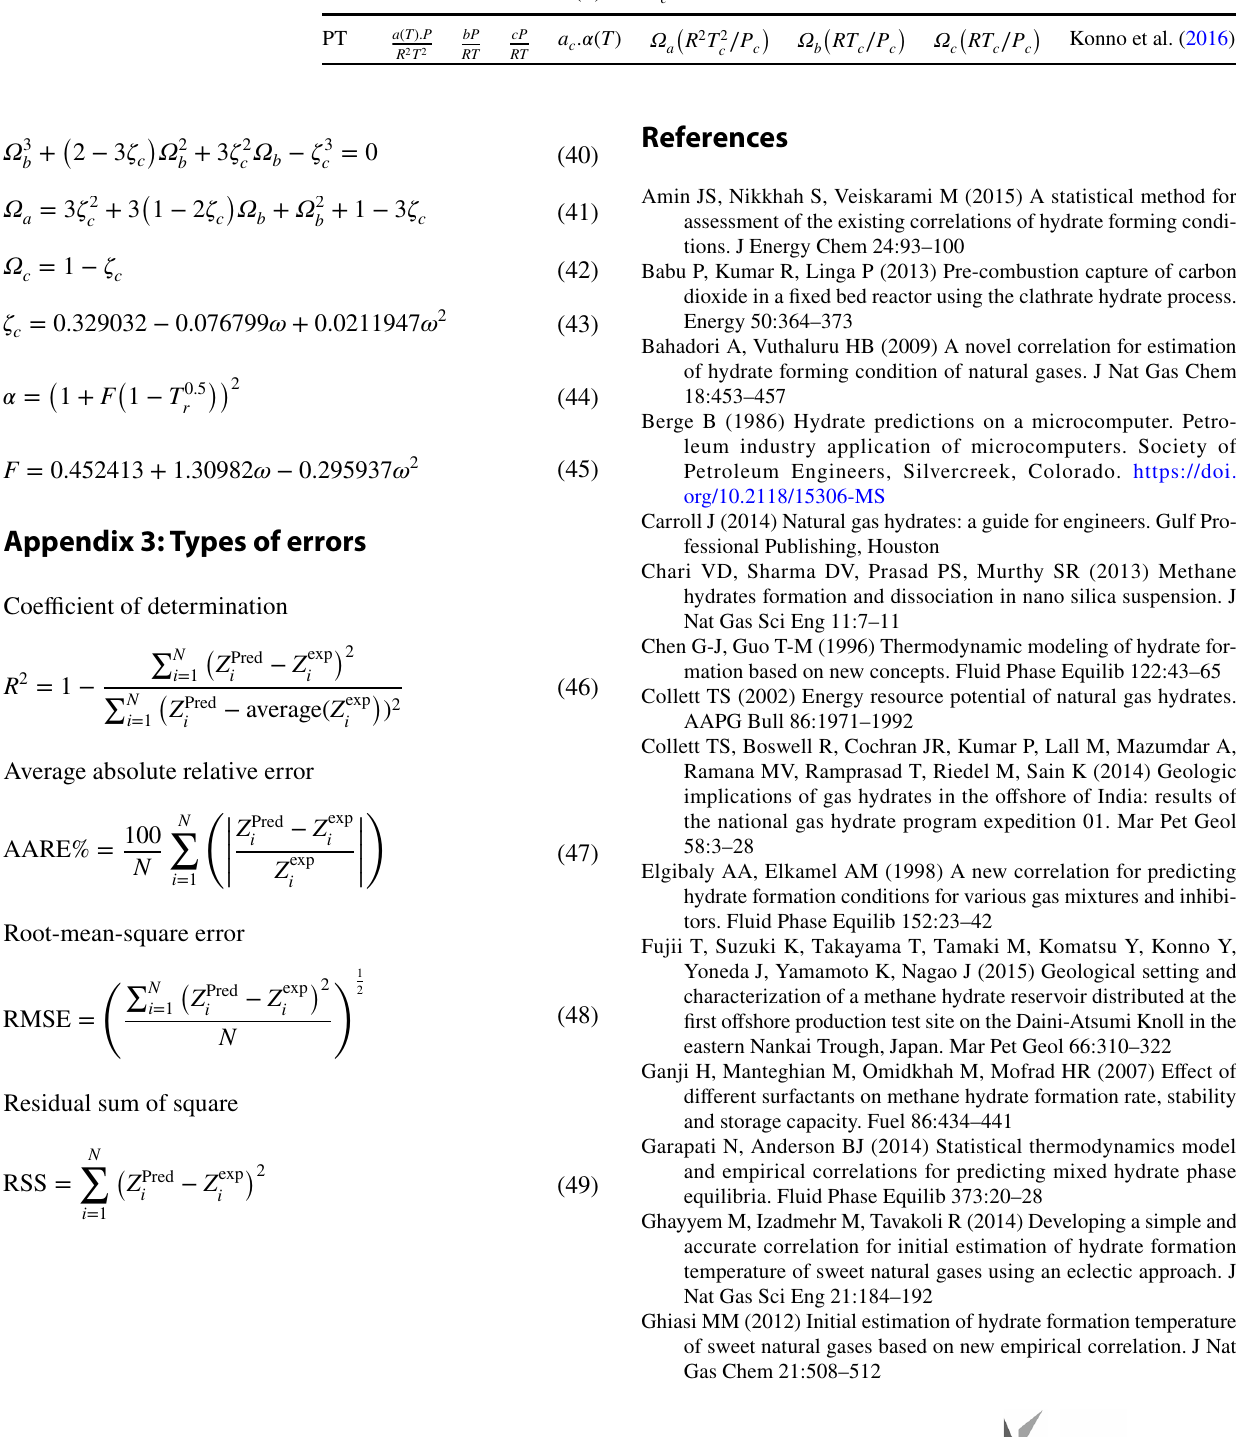
Table 13 PT EOS